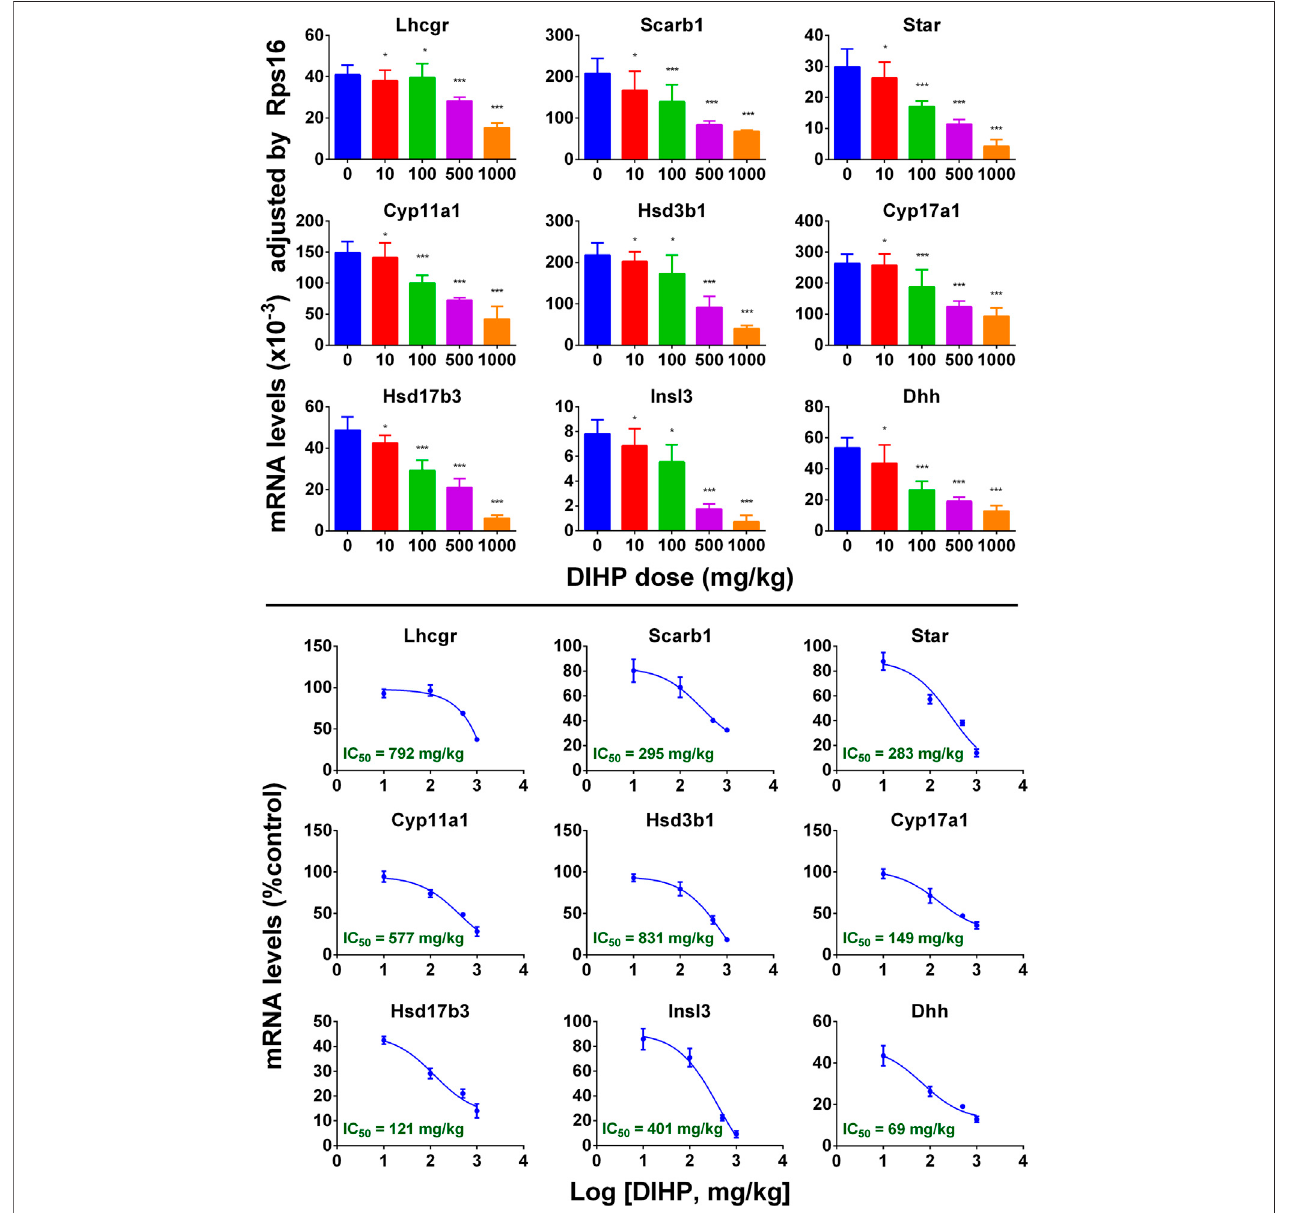
FIGURE4| qPCRanalysisofmRNAlevelsintestesafterexposuretoDIHPinpregnancy.ThedamwasgavagedwithdifferentdosesofDIHPfromGD12toGD21. Lower panel: IC 50 value. Data are expressed as mean ± SEM, n (cid:1) 6; * p > 0.05, ** p < 0.05, *** p < 0.01 indicate that the signi fi cant level between the DIHP group and the control group,